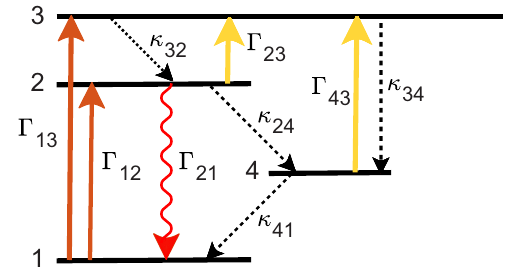
FIG. 16. General electronic level